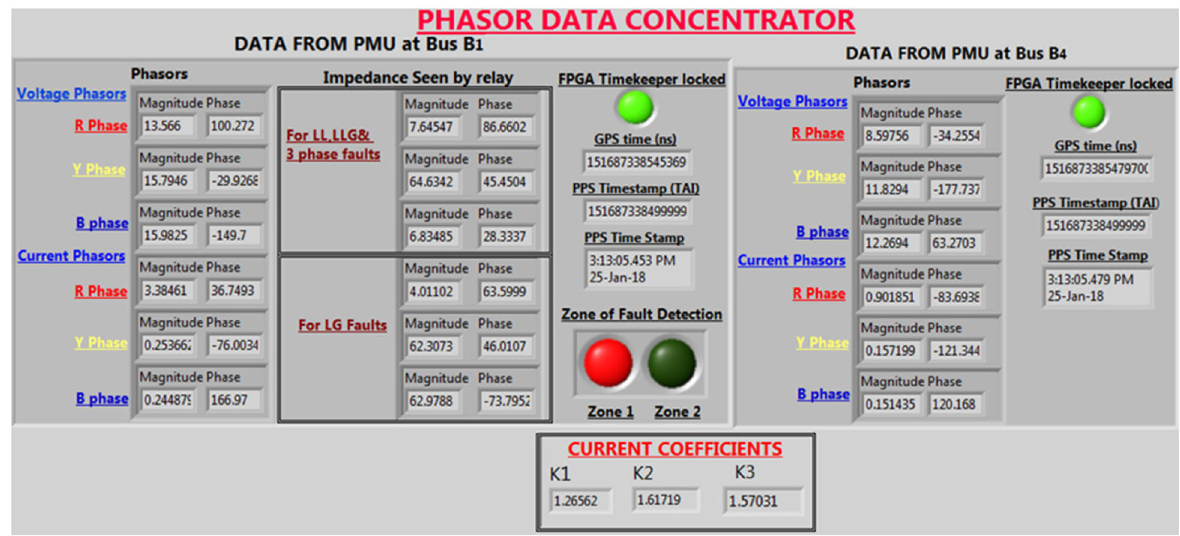
Fig. 13 LabVIEW front panel display of PDC at SPC showing the performance of distance relay R A with the proposed PAZSD methodology for an LG fault (FR = 0.2 Ω ) at 50 km from B